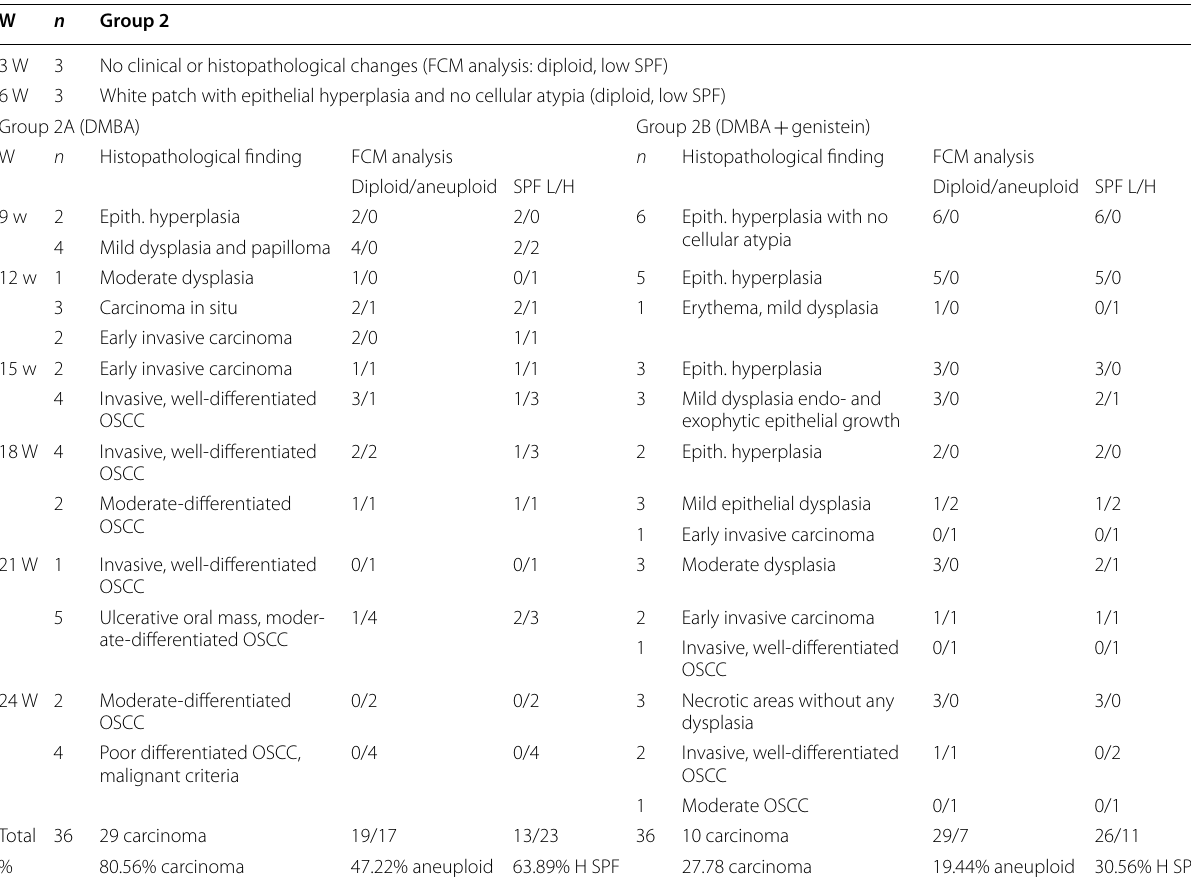
Table 1 The summary of the histopathological finding and flow cytometry (FCM) analysis of hamsters’ buccal pouch. The tumorigenesis has been induced using DMBA. Genistein has been administrated orally to group 2B as a possible chemo-suppressor for tumorigenesis. SPF , S-phase fragment; w , week; n , number of